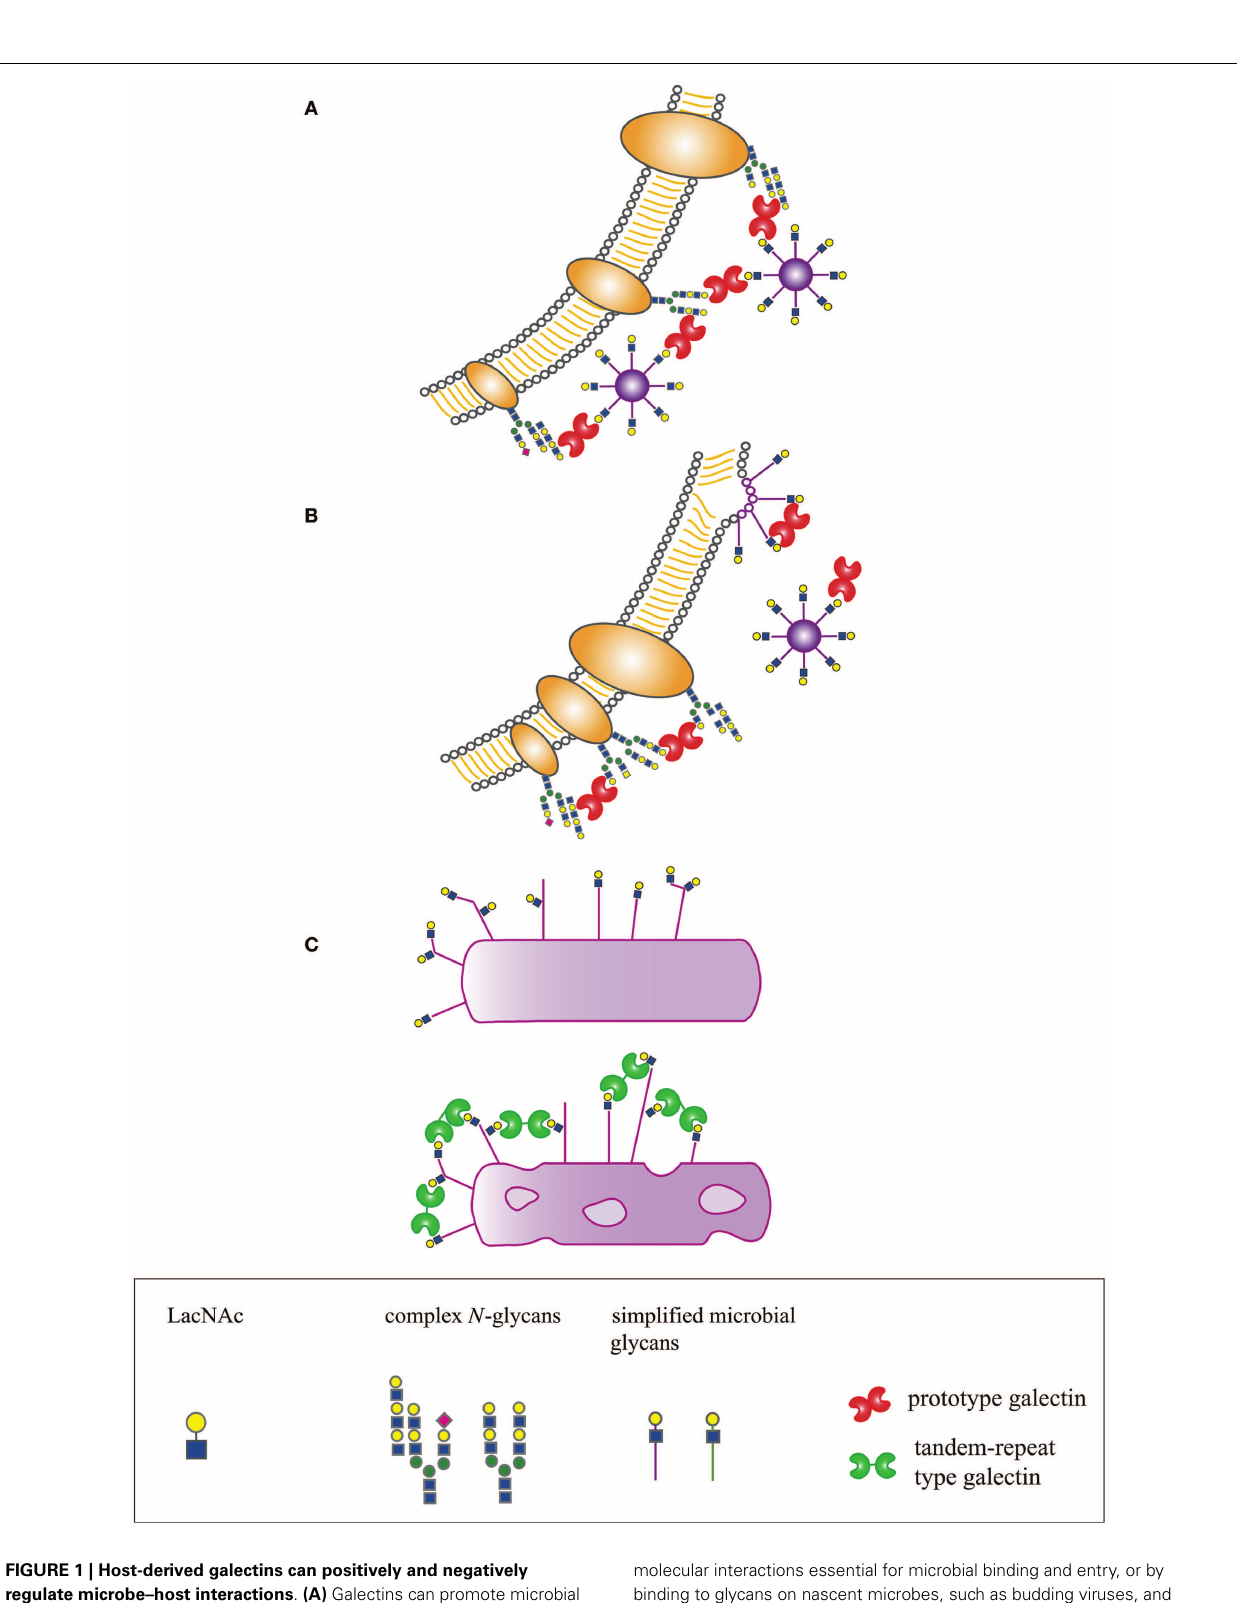
molecular interactions essential for microbial binding and entry, or by binding to glycans on nascent microbes, such as budding viruses, and preventing proper structural assembly. (C) Galectins can be directly microbicidal, an effect regulated by expression of specific glycan ligands on the pathogen